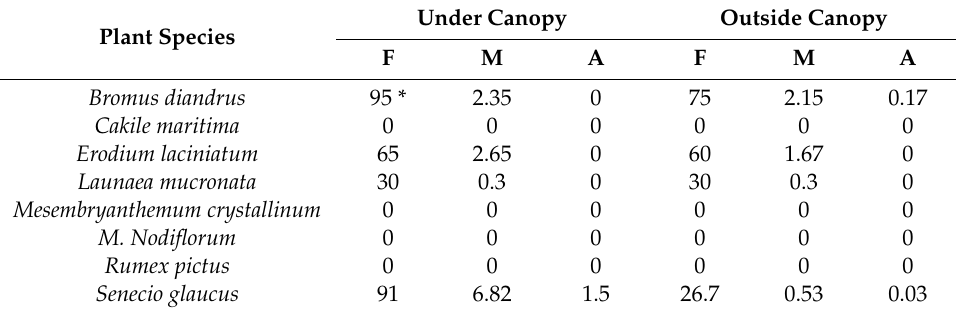
Table 3. Mycorrhizal colonization level (%) in roots of the selected plant species under and outside the canopy of C. polygonoides .